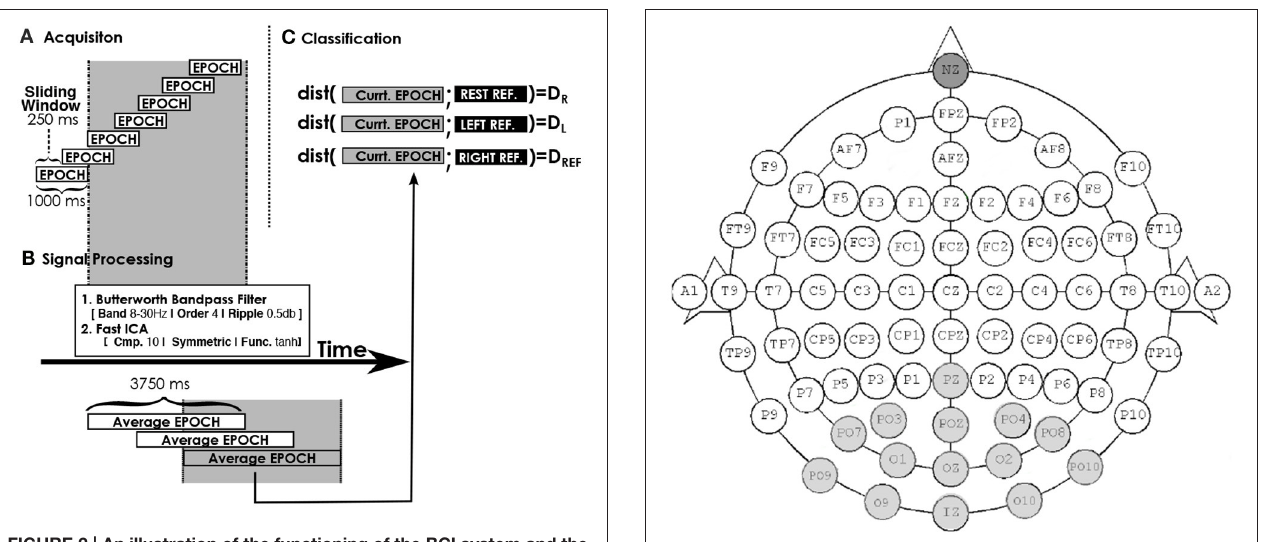
the g.tec USBAmp. The dark gray electrode is the reference, the light gray ones are the CI electrodes.